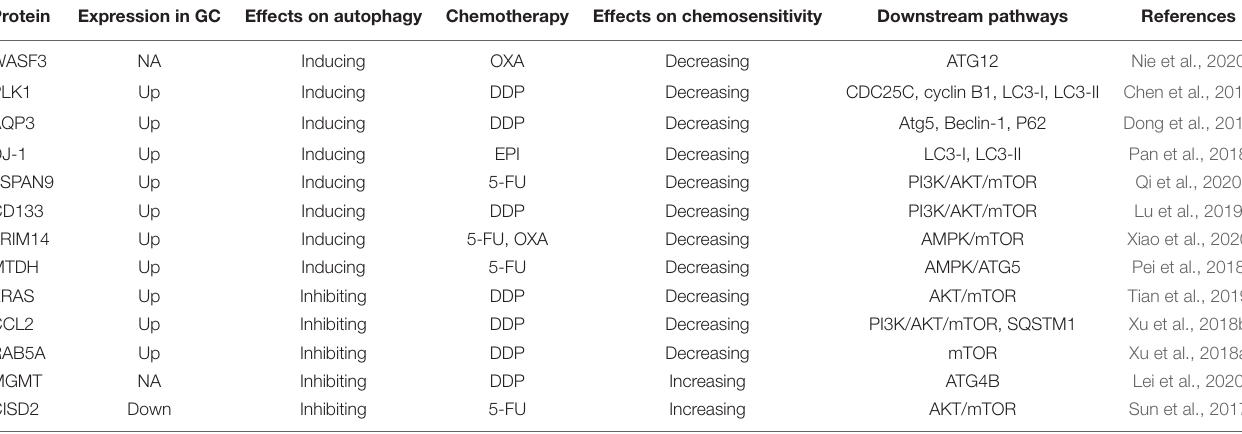
TABLE 1 | Key regulatory proteins in autophagy-mediated chemoresistance of gastric cancer. Protein Expression in GC Effects on autophagy Chemotherapy Effects on chemosensitivity